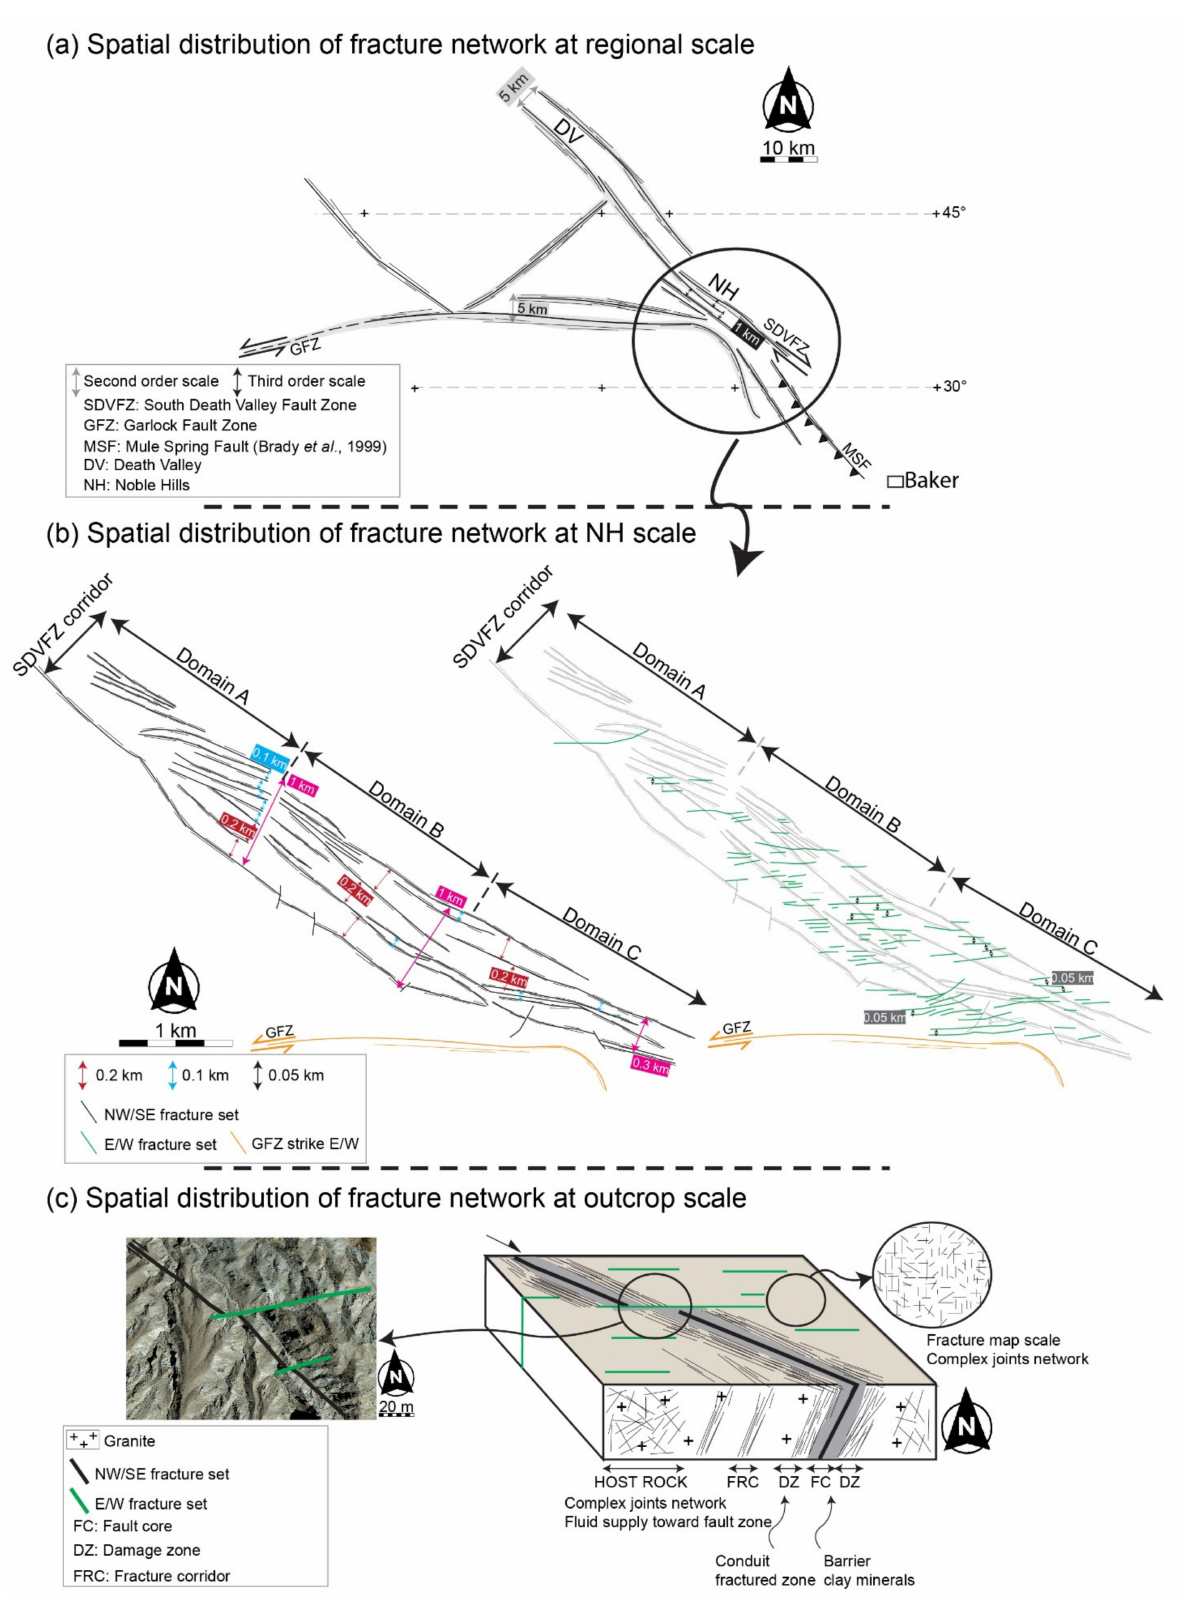
Figure 12. Conceptual scheme presenting the spatial arrangement of the NH fracture network at ( a ) regional scale, ( b ) NH scale, and ( c ) outcrop scale. The organization is based on scale orders referring to the [16,17,20,30] classification, and their associated spacing characteristics referring to [20,30]. The picture presented in ( c ) is provided by GoogleEarth ®